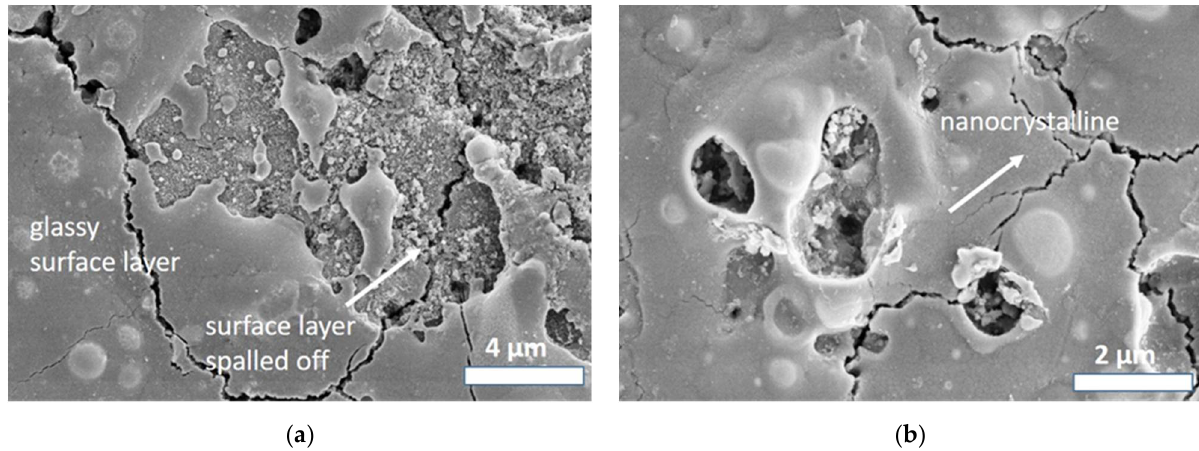
Figure 8. Detail SEM images of ED-machined surfaces of 28 WC-1400. ( a ) 28 WC-1400 machined with parameter set EDM 1 showing a part of the sample covered by a smooth glass-like surface layer. ( b ) 28 WC-1400 machined with parameter set EDM 2, showing that the surface layer is not amorphous but nanocrystalline.